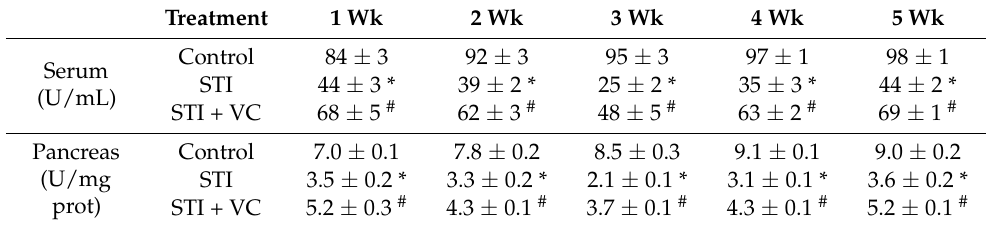
Table 7. Change of TPS activity in serum and pancreas.